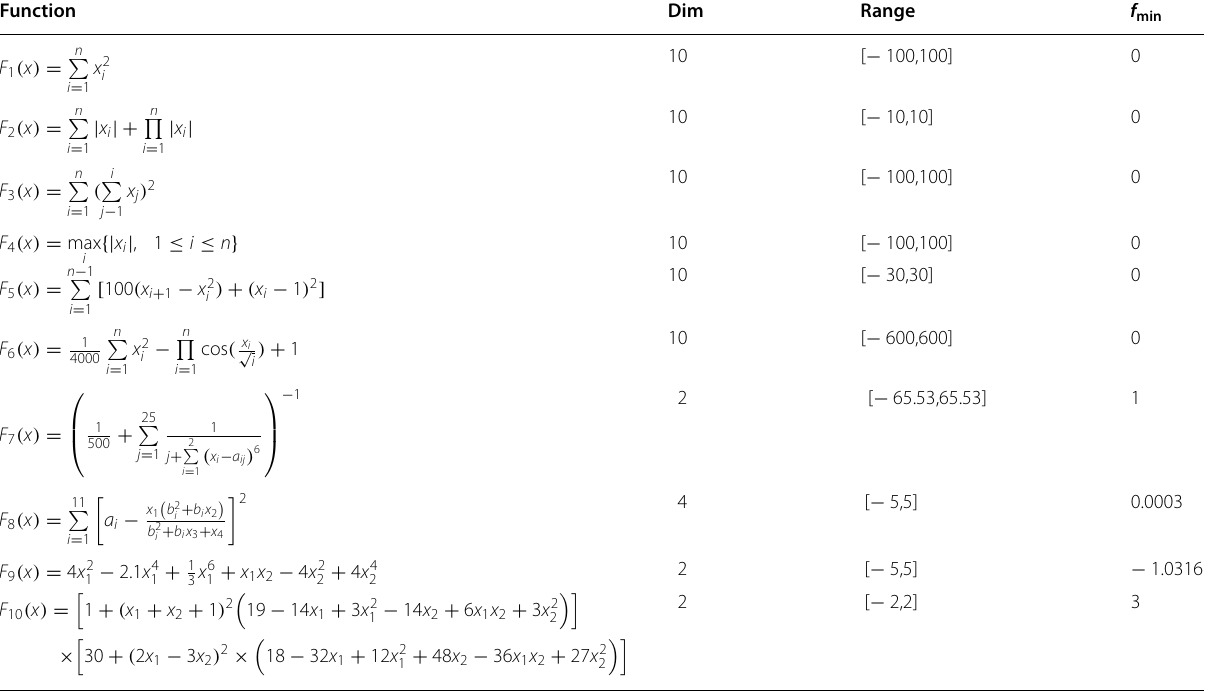
algorithm. The convergence curve shows the best solution obtained by each algorithm throughout the Table 2 Test functions description.